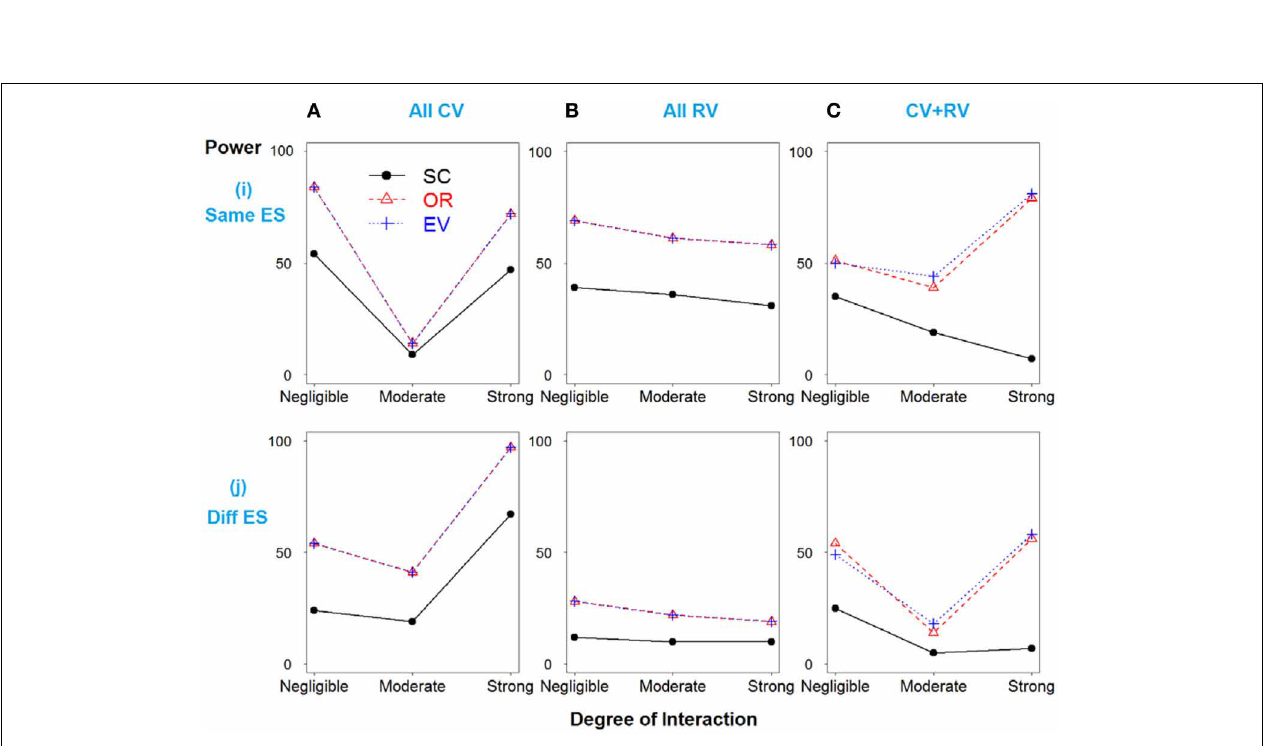
FIGURE 2 | Power comparison for the interaction model with two deleterious SNPs. Panels by column: (A) All SNPs are common variants. (B) All SNPs are rare variants. (C) SNPs 1 and 3 are